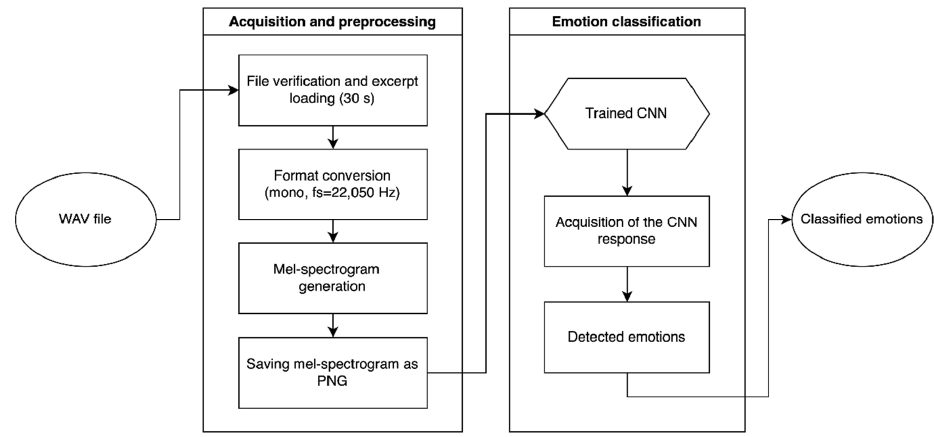
Figure 9. Block diagram of the constructed system.